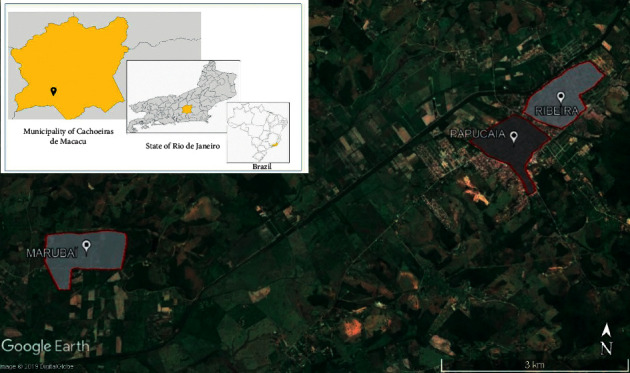
Basic rocket ship design. The rocket ship is propelled with three thrusters and features a single viewing window. The nose cone is detachable upon impact.